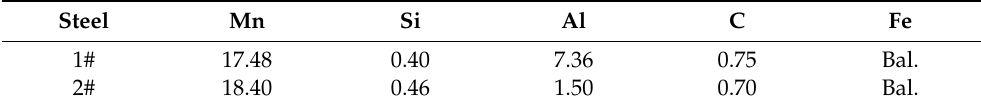
Table 1. Chemical composition of experimental steels